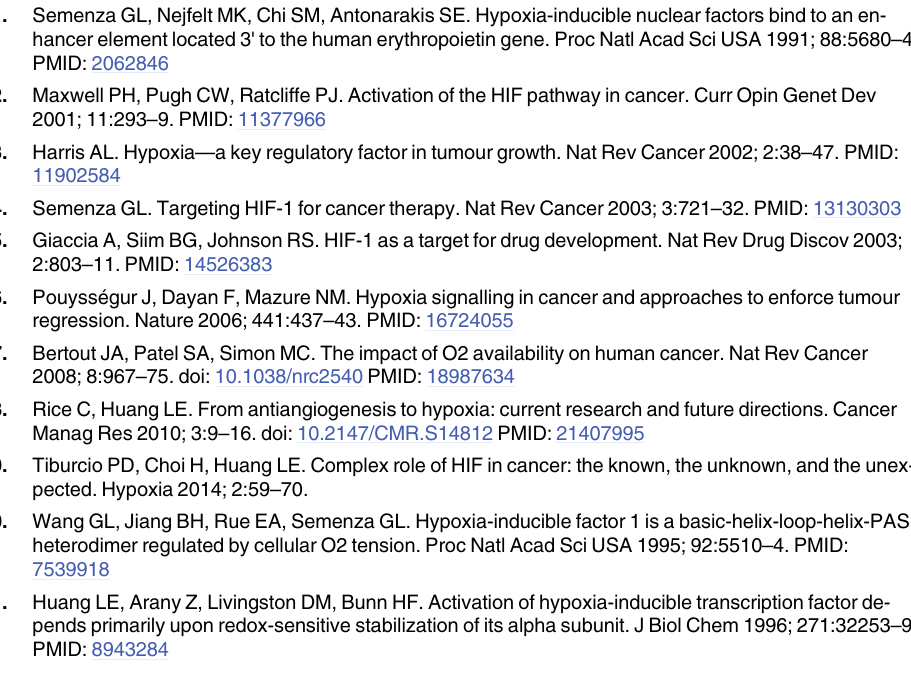
S3 Fig. Intracranial tumor lesions derived from U-87 MG variants after intermittent induc- tion. (A) Invasive lesions were seen occasionally in tumors derived from β -gal cells (XG021), presented at 25× and 200× magnifications, with scale bars of 1 mm and 100 μ m, respectively. (B) Additional lesions of widespread invasion derived from HIF1 α (PP) cells are shown (XG042). Scale bar, 100 μ m. Tumor lesions are demarcated in dash lines. (TIF) S4 Fig. Additional malignant features of intracranial tumors derived from transduced GSC20. Invasive lesions were identified in the hindbrain of NSG mice injected with β -gal- transduced GSC20 (XG198) and HIF2 α (PP)-transduced GSD20 (XG205). Tumor lesions also contained necrosis (XG198) and invasion in the forth ventricle (XG205, arrowhead). Vascular proliferation and multi-nucleation were observed commonly in these tumor lesions. Images are presented at 25× and 200× magnifications, with scale bars of 1 mm and 100 μ m, respectively.